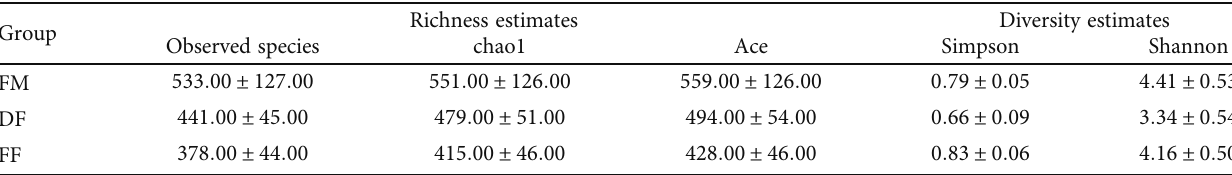
Figure 4: Taxonomic levels of the top ten phyla (a) and genera (b) in relative abundance. Table 6: Alpha diversity index of the intestinal microbiota of